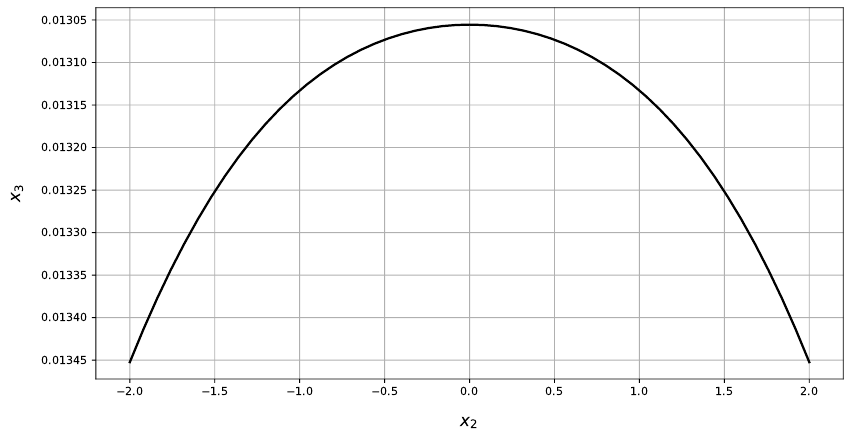
Figure 9. The deflection in section x 1 = 0 of a rectangular plate with two opposite edges simply supported and the other free.